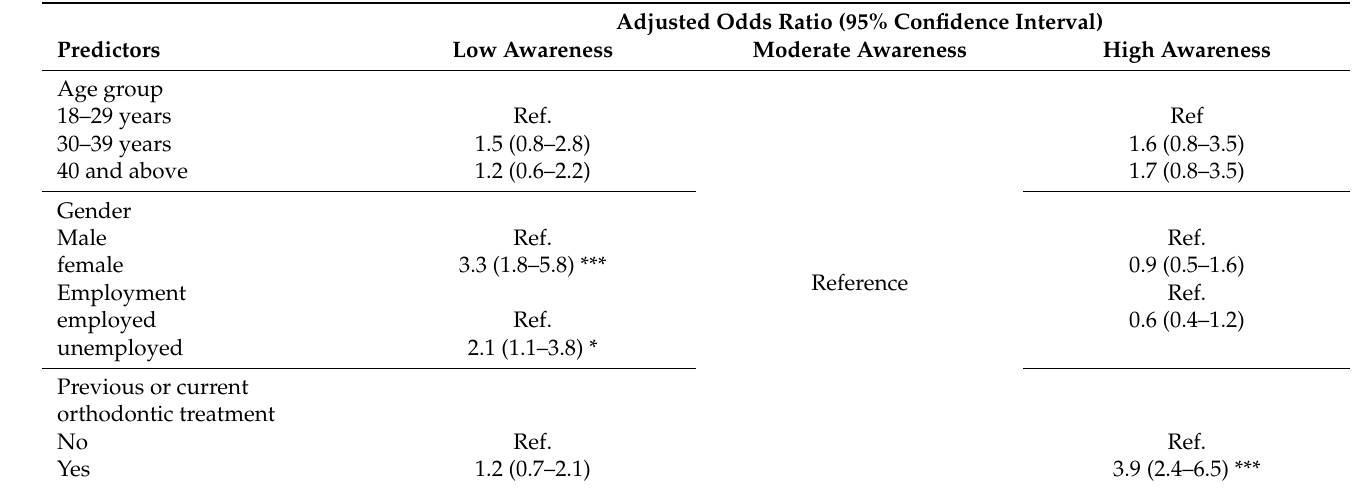
Table 4. Adjusted Odds Ratios of demographic predictors for parents’ awareness